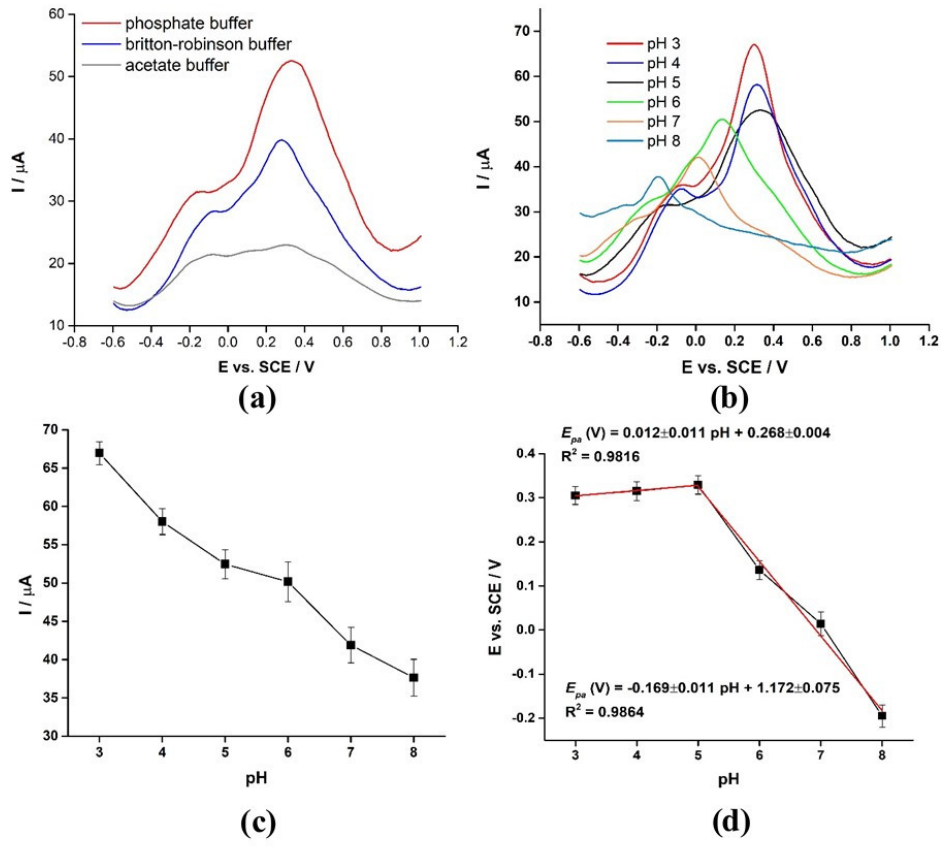
Figure 7. ( a ) Comparison of SWV curves in different buffer electrolytes, ( b ) SWV curves as a function of pH, and plots of ( c ) I vs. pH and ( d ) E vs. pH.